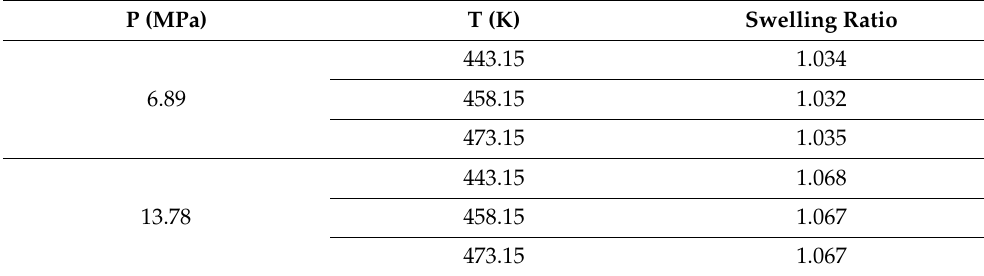
Table 11. Swelling ratios for PS + CO 2 at various temperatures and pressures using